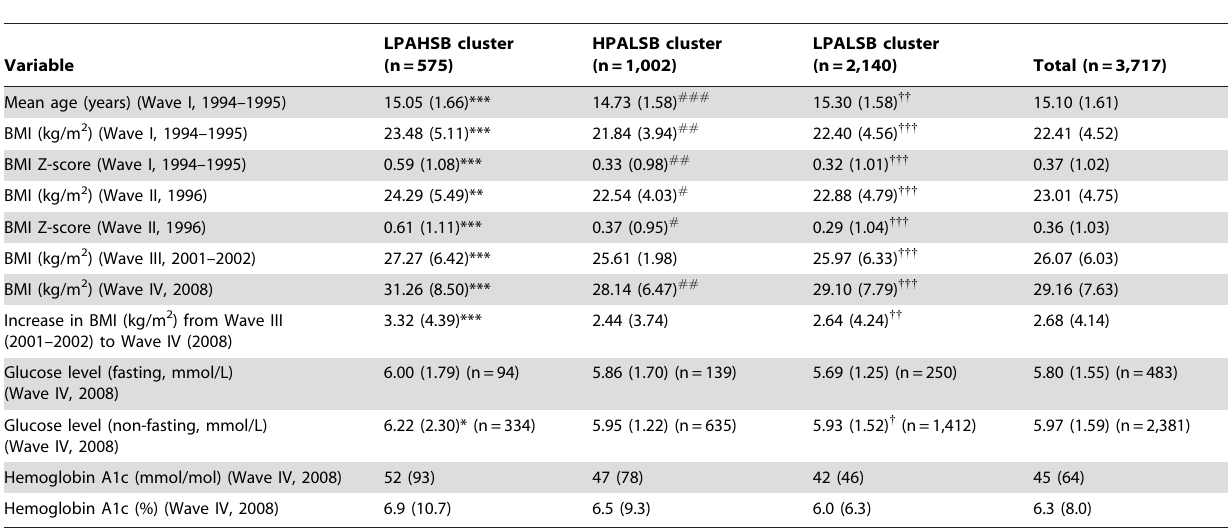
Table 3. Characteristics of the three clusters and the total sample (continuous variables).